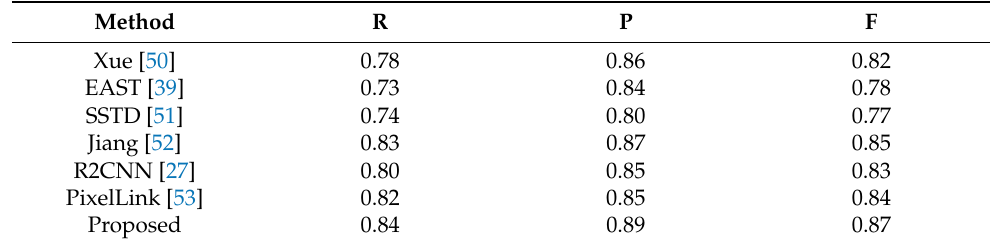
Table 6. Comparison of text detection results of various methods on the ICDAR 2015